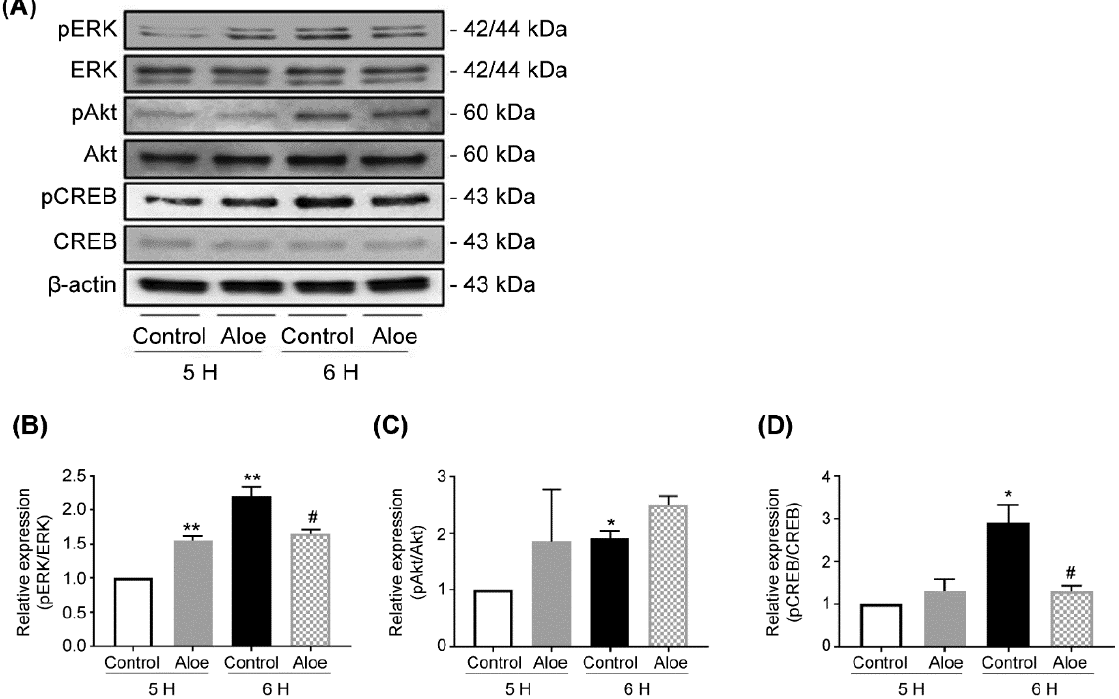
Figure 4. Effects of Aloe (AV) on the phosphorylation of ERK, CREB, and Akt. ( A ) Cells were treated with 10 μ g/mL AV in both 5H and 6H media conditions, and protein expression of phosphorylated ERK, CREB, and Akt were measured. ( B – D ) Densitometric analysis of pERK, pAkt, and pCREB. Data were represented as means ± SD ( n = 3); * p < 0.05, ** p < 0.01 versus 5H control; # p < 0.05 versus 6H control.